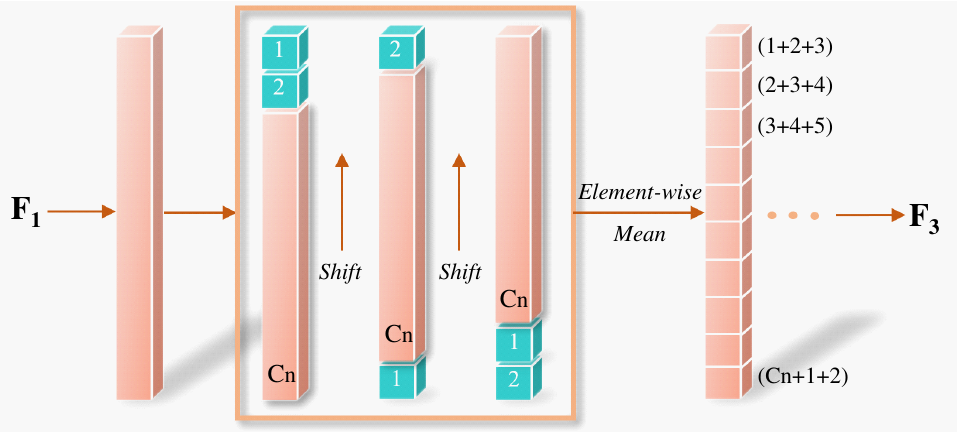
Figure 8. Shift pooling